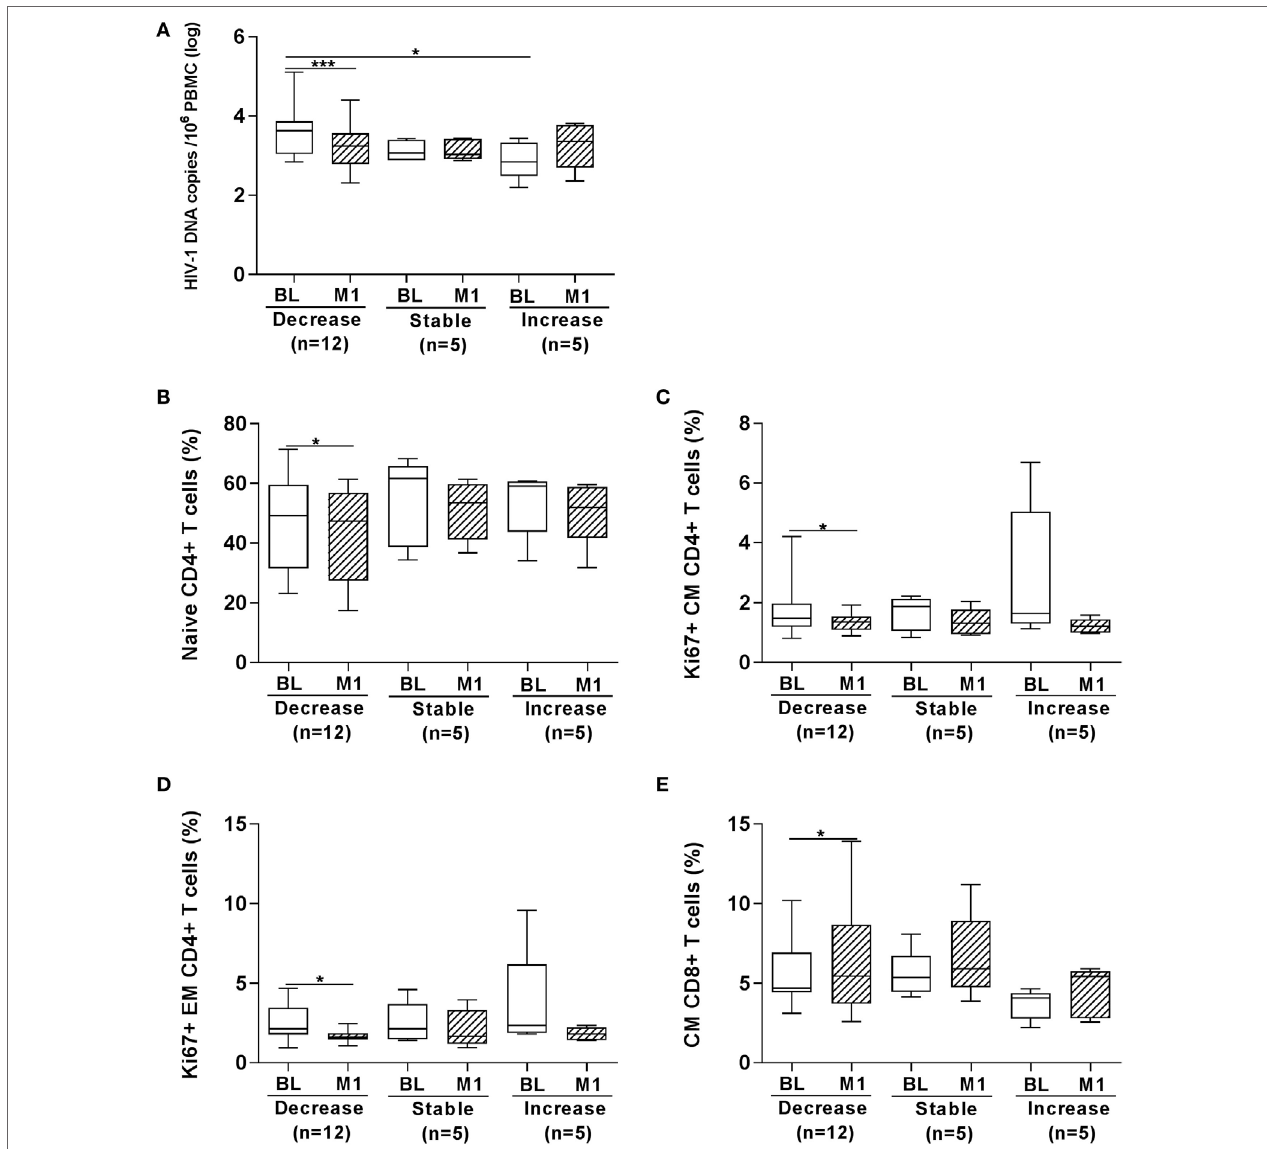
FigUre 5 | Frequency of T-cell subpopulations according to changes in HIV-1 DNA copies at 1 month from vaccination. HIV-1 DNA copies/10 6 peripheral blood mononuclear cells (PBMCs) were measured in PBMCs from 22 HIV-1-infected children (a) . In the group “decrease,” 12 children are included who displayed > 10% decrease in the number of HIV-1 DNA copies at 1 month from last vaccination as compared with BL value; in the group “stable,” 5 children who displayed minor variations ( < 10%) between the two time points are included; in the group “increase,” 5 children were included showing an increased ( > 10% variation) number of HIV-1 DNA copies at 1 month. In the three groups of children divided according to whether the HIV-1 DNA copies in PBMCs decreased, remained stable or increased at month 1 from vaccination we found that the frequency of naïve CD4 + T cells (B) , Ki67 + CM CD4 + T cells (c) and Ki67 + EM CD4 + T cells (D) was reduced in the “decrease” group; in the same group an increase in CM CD8 + T cells (e) was revealed at month 1. BL, baseline; M1, month 1. * p < 0.05; **** p <